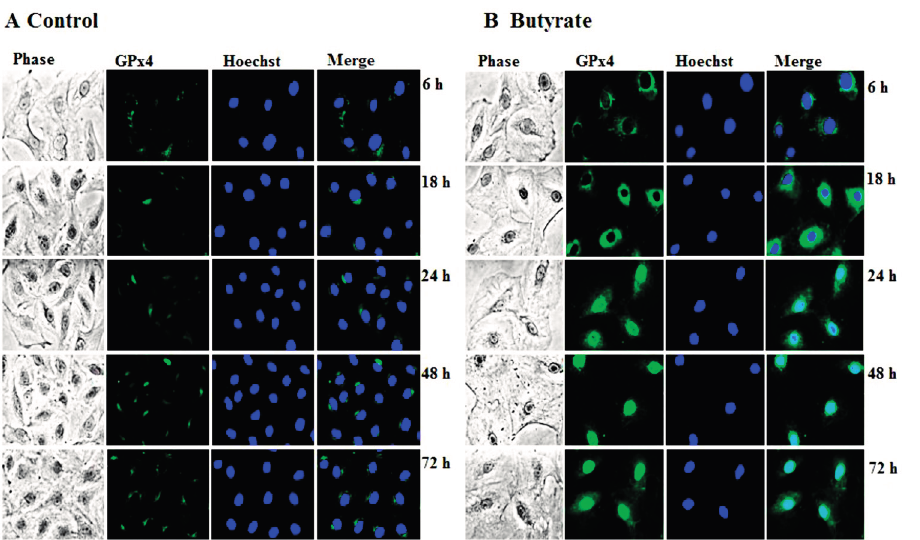
Figure 4. Intracellular localization of butyrate-induced GPx4 expression in VSMC. VSMC untreated ( A ) or treated ( B ) with 5 mM butyrate for different periods of time were processed for immunostaining of GPx4 with an antibody specific to GPx4 followed by Alexa flour 488 conjugated second antibody, as described in the Experimental Section. (400×